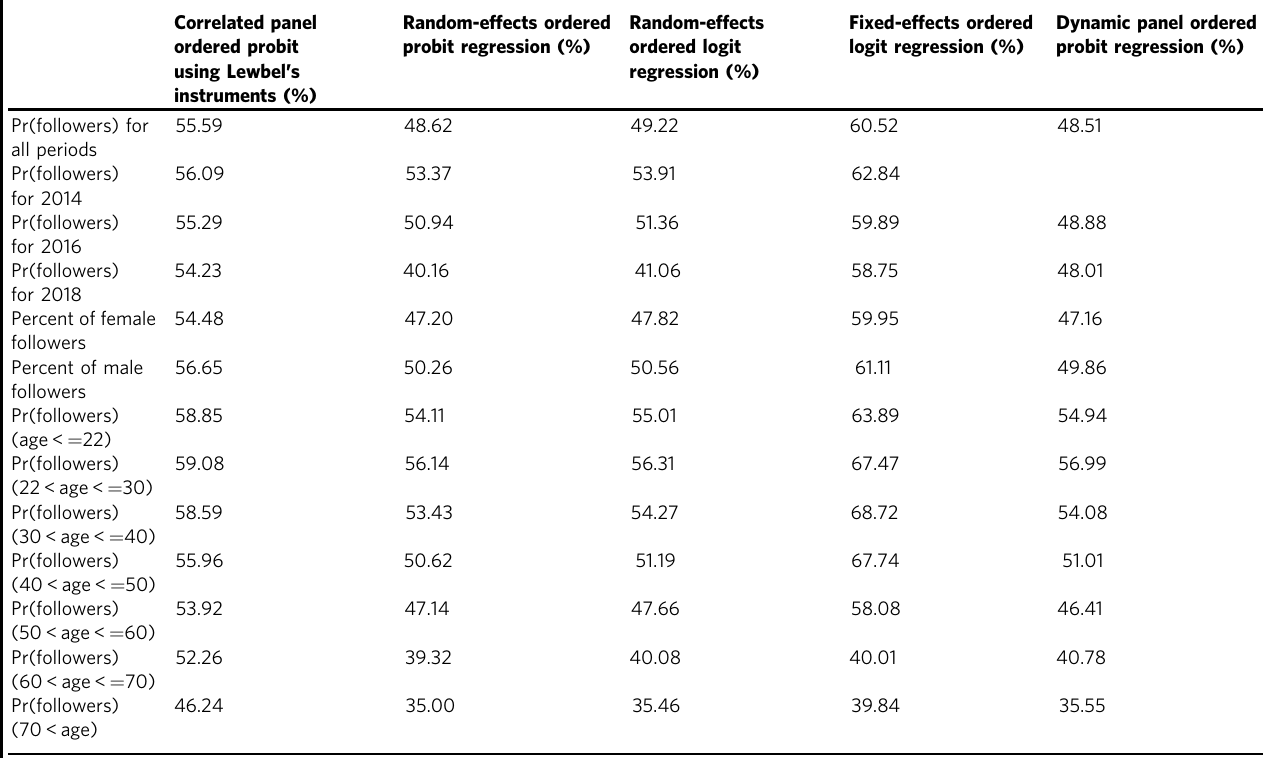
Table 5 Estimated relative frequency of followers in the population from fi ve discrete